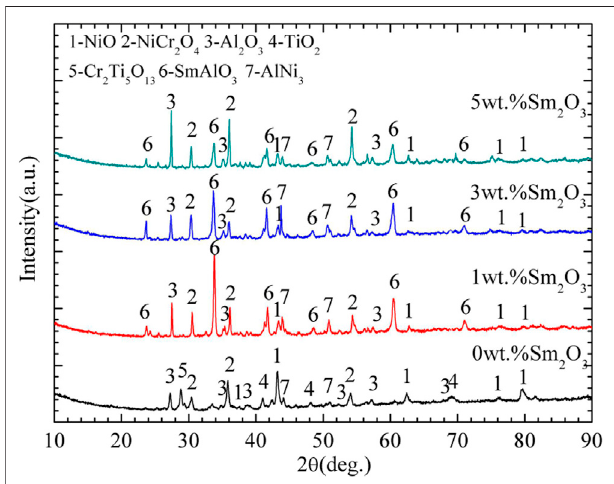
Frontiers in Materials |